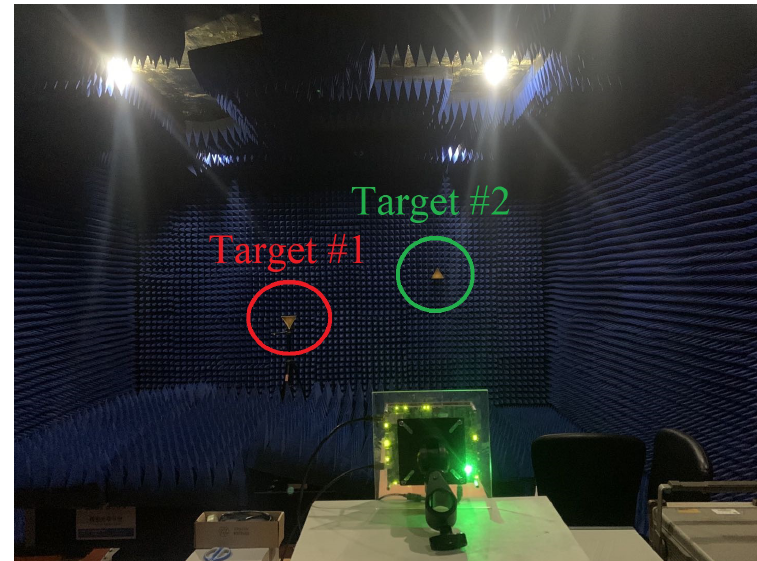
Figure 14. Two-target scenario for dataset collection. To obtain the low-resolution image, the low-density intervals were set as [ 1 ◦ , 1m ] . Figure 15a,b shows the low-resolution imaging results obtained from the experimental data of one and two targets, respectively, using the method proposed in Section 3.1. It is obvious that the peak value in the 2D image does not represent the targets’ positions accurately due to the large grid division.